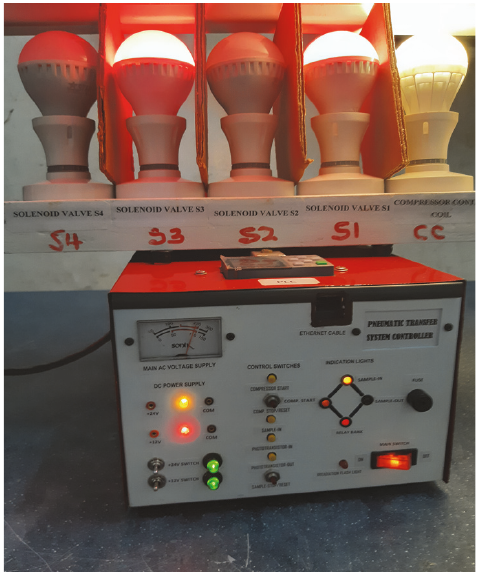
Figure 15: Sample-in button depressed, solenoid valves (S1 and S3)